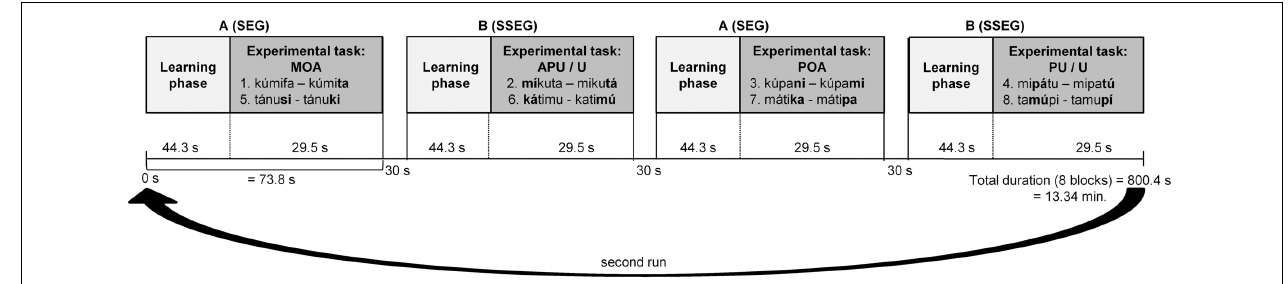
FIGURE 1 | fMRI design with 8 blocks (sequence A-B-A-B-A-B-A-B). Each block started with a learning phase followed by the experimental task. SEG, segmental; SSEG, suprasegmental; APU, Antepenultima; MOA, Manner and place of articulation; POA, Place of articulation; PU, Penultima; U, Final